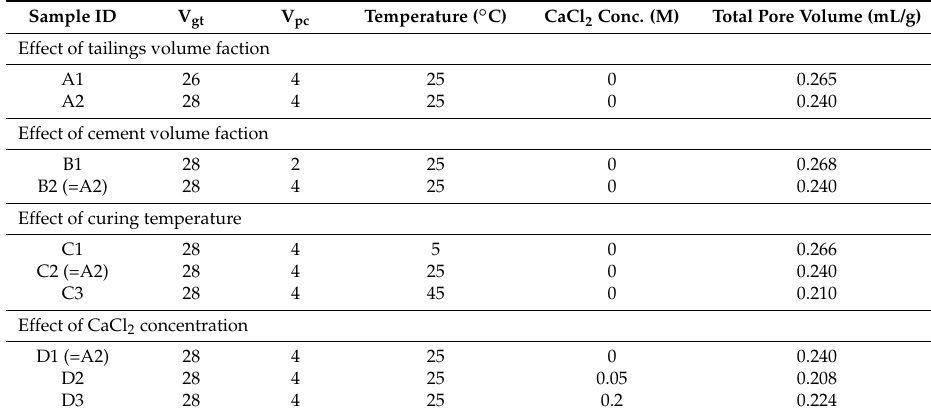
Table 2. Summary of mix proportion and total pore